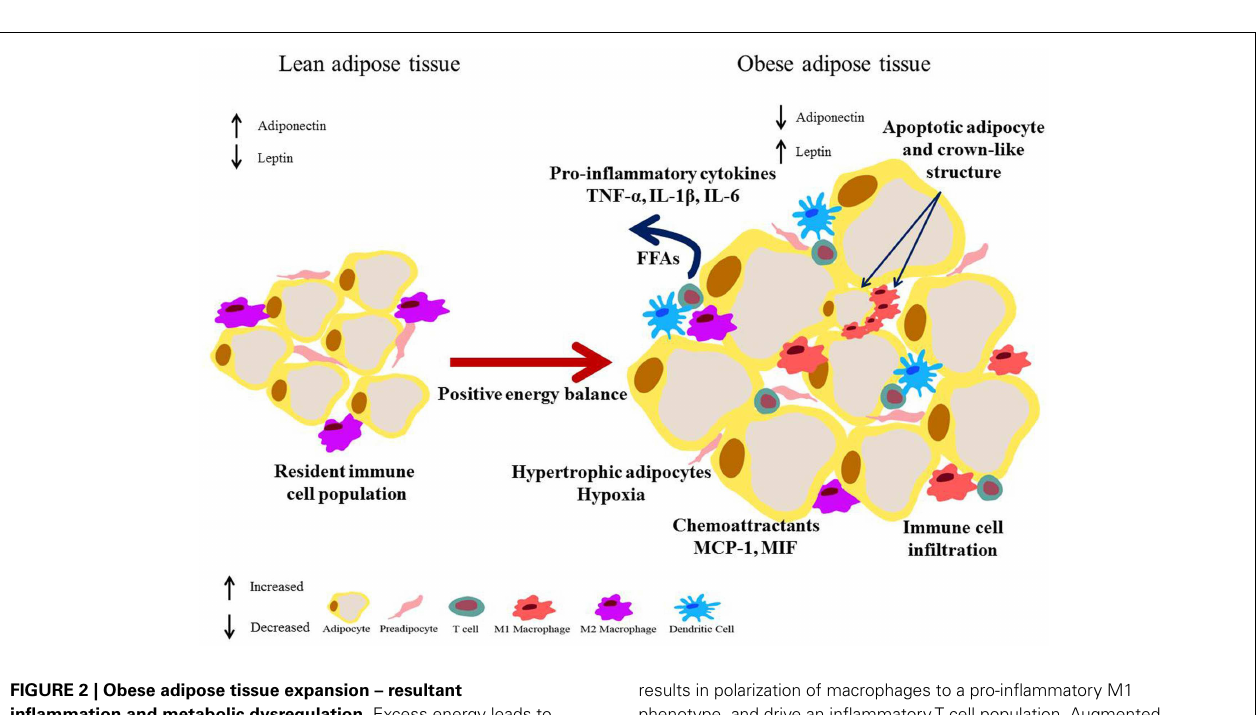
FIGURE 2 | Obese adipose tissue expansion – resultant inflammation and metabolic dysregulation . Excess energy leads to adipose expansion with hypertrophic adipocytes that secrete chemoattractants such as MCP-1, drawing immune cells into the tissue. Secretion of pro-inflammatory mediators such asTNF- α , IL-1 β , and IL-6 by adipocytes, pre-adipocytes, and infiltrating immune cells